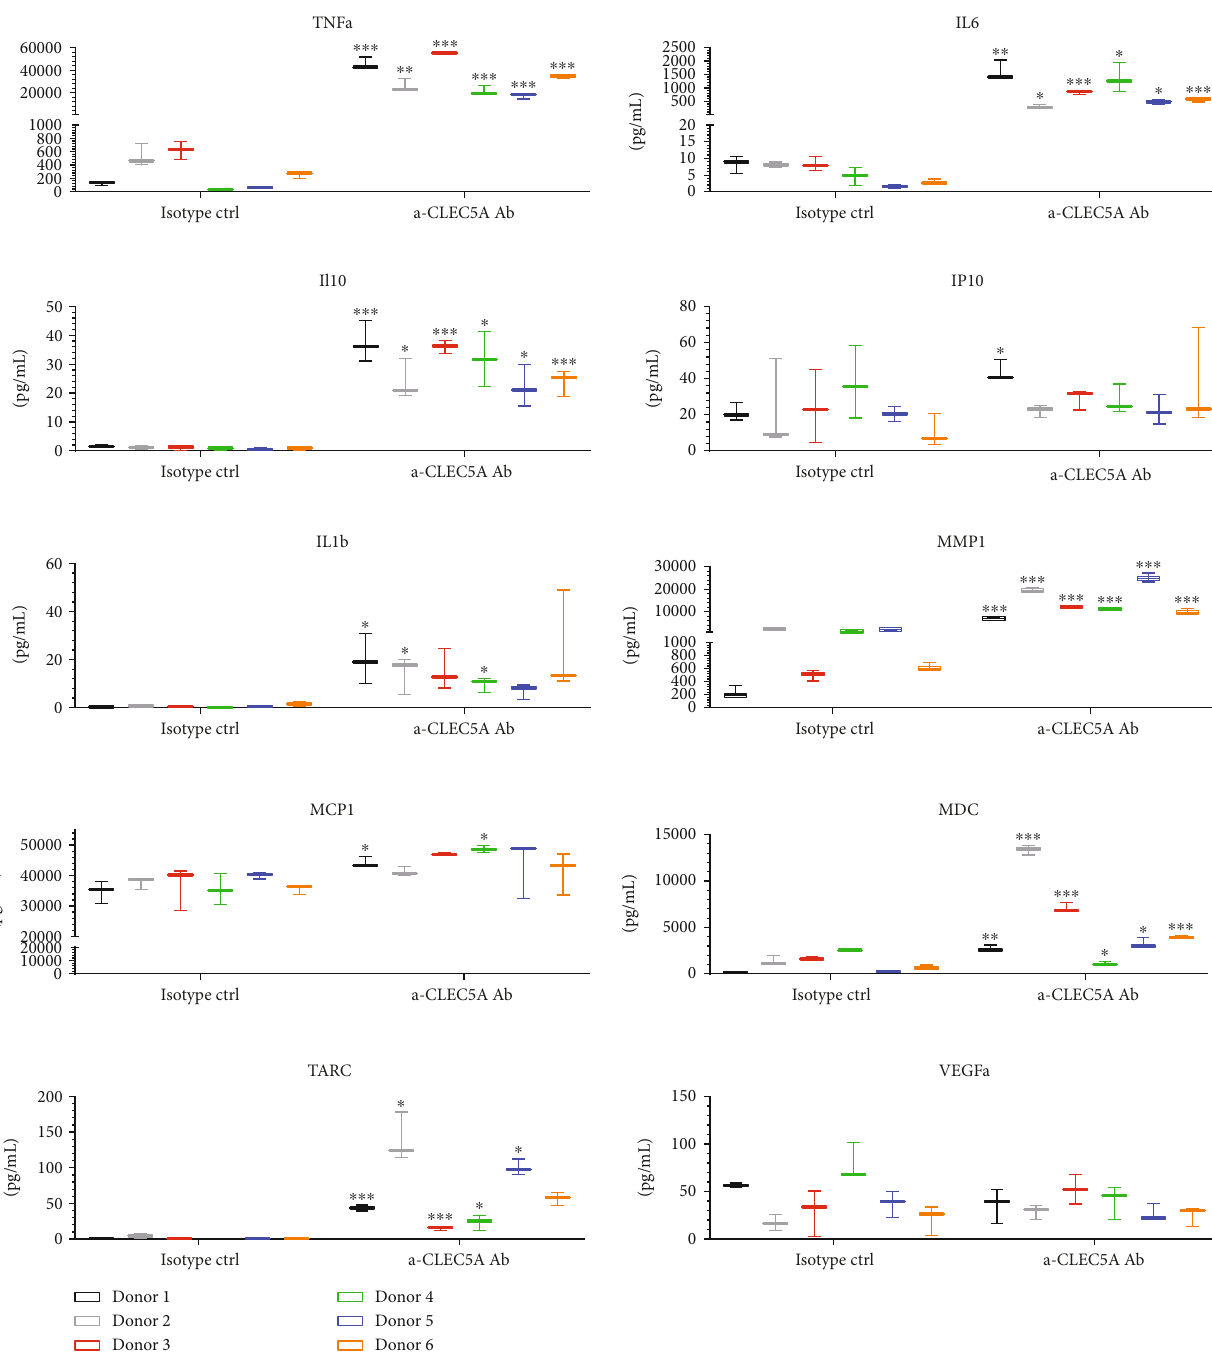
Figure 5: Antibody-mediated activation of the CLEC5A receptor on human MdM leads to a mixed cytokine response. Monocytes isolated from six donors were di ff erentiated into M0 MdM and then transferred onto culture plates coated with 10 μ g/ml α -CLEC5A Ab or with the isotype ctrl. Cell culture supernatants were harvested 24 h later and tested for several cytokines with MSD or ELISA kits. Values represent the mean ± SD from three technical replicates per each donor. Shown is the summary result of two independent experiments with n=6 donors; ∗ p < 0 : 033 , ∗∗ p < 0 : 002 , and ∗∗∗ p < 0 : 001